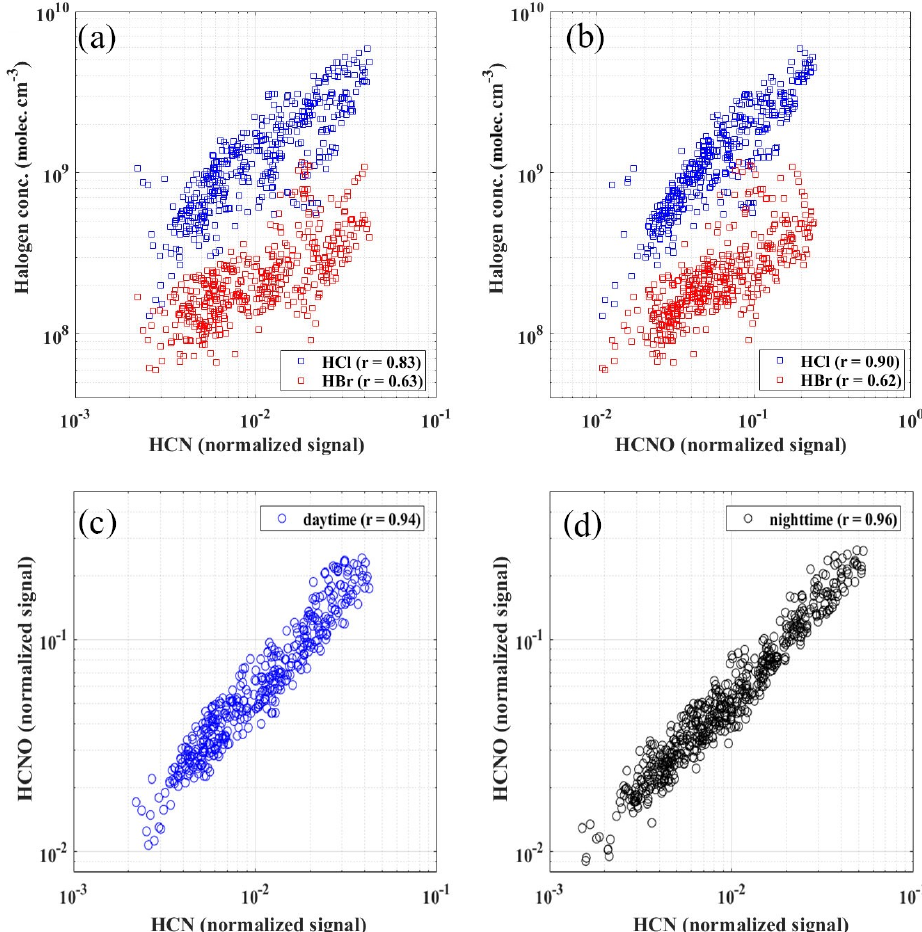
Figure 7. The relationship of HCl and HBr concentrations with HCN and HCNO during the daytime (08:00–17:00) (a, b) and the correlations between HCN and HCNO during both daytime (08:00–17:00) (c) and nighttime (18:00–07:00 the next day) (d) .